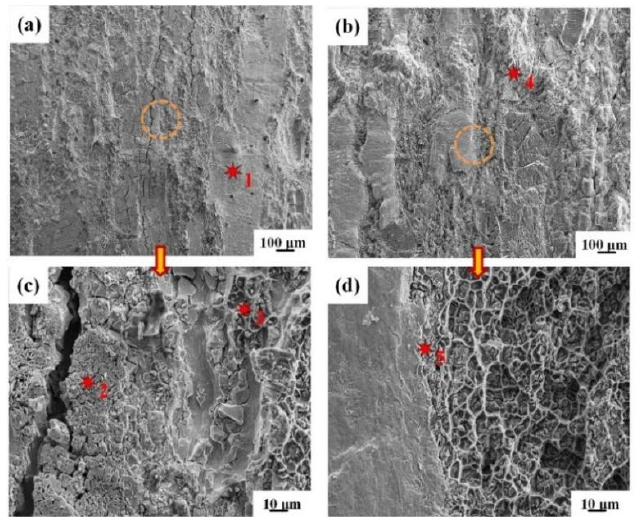
Figure 9. SEM images of Cu and Al surfaces for IFR-550 after peeling test: ( a ) Cu side, ( b ) Al side, ( c , d ) enlarged images of the circles in the ( a , b ). Table 2. Chemical composition of corresponding points at the peeling surface of IFR-550 (at. %). Points